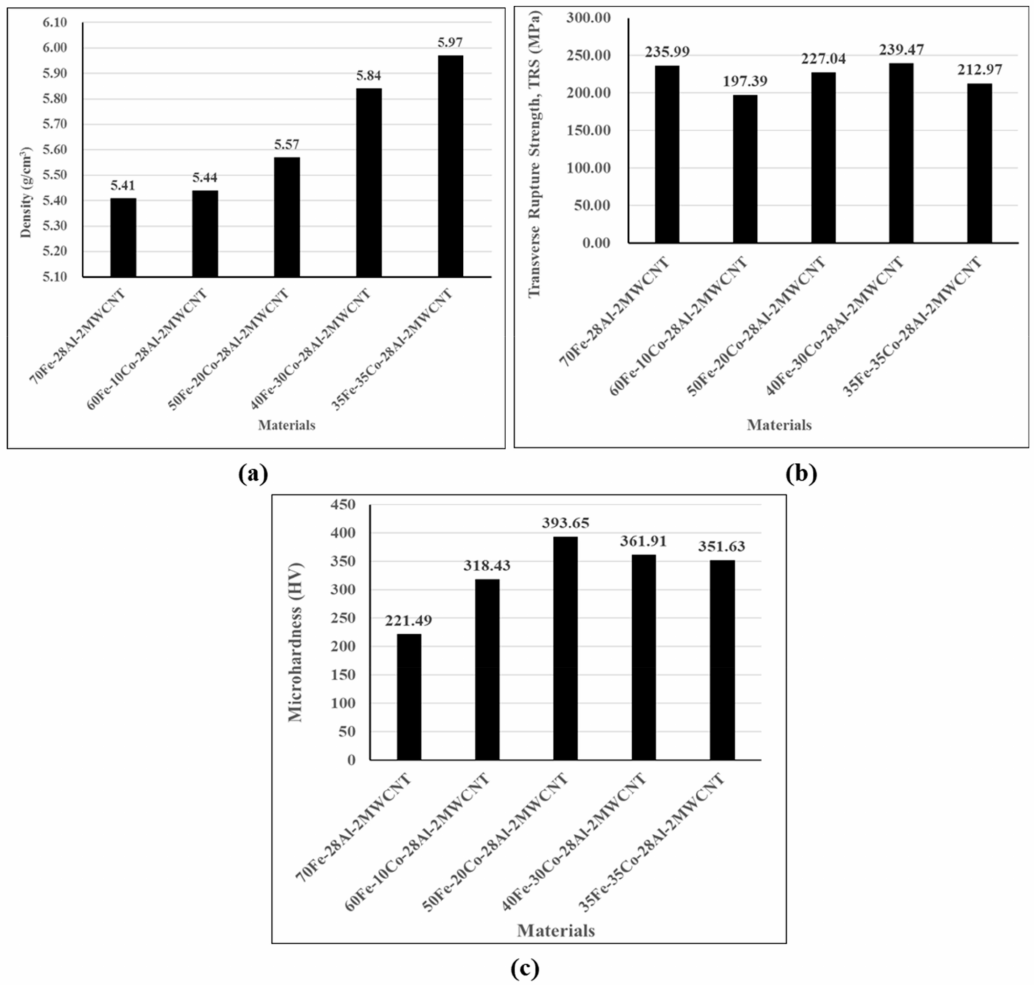
Figure 12. E ff ect of Co volume content on ( a ) volume density; ( b ) transverse rupture strength (TRS); and ( c ) Vickers microhardness of Fe-Co-Al-MWCNT